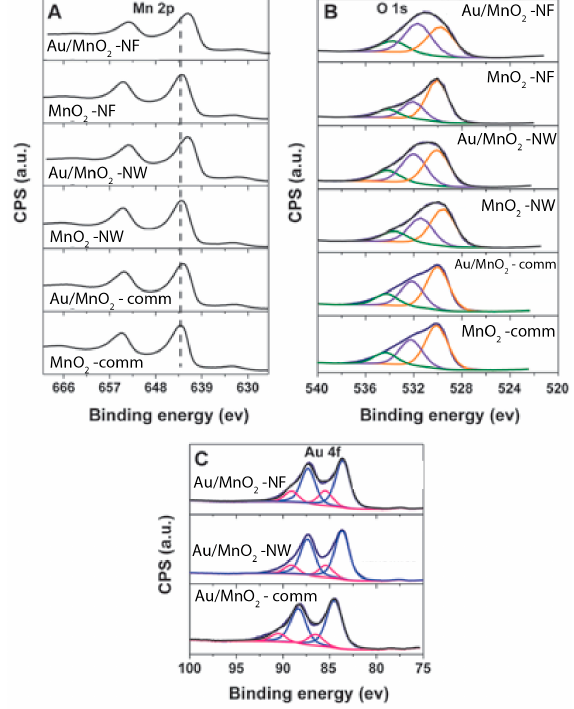
Figure 5. XPS spectra of Mn 2p ( A ), O 1s ( B ) and Au 4f ( C ) regions for the prepared catalysts.